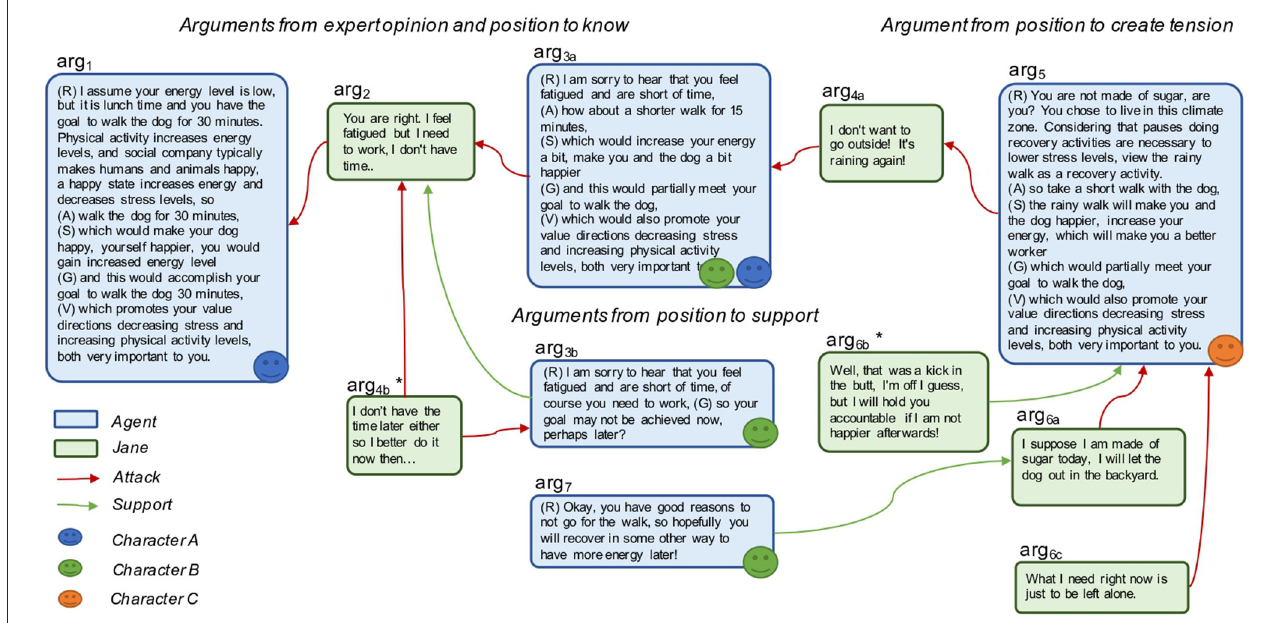
FIGURE9 Attacking (challenging) (red arrow) and supporting (green arrow) arguments posed by the agent (blue) and Jane (green). The agent can choose between a supportive argument or a challenging argument as a response to Jane’s first argument, which could lead to different outcomes. The arguments arg4b * and arg6b * indicate the desired